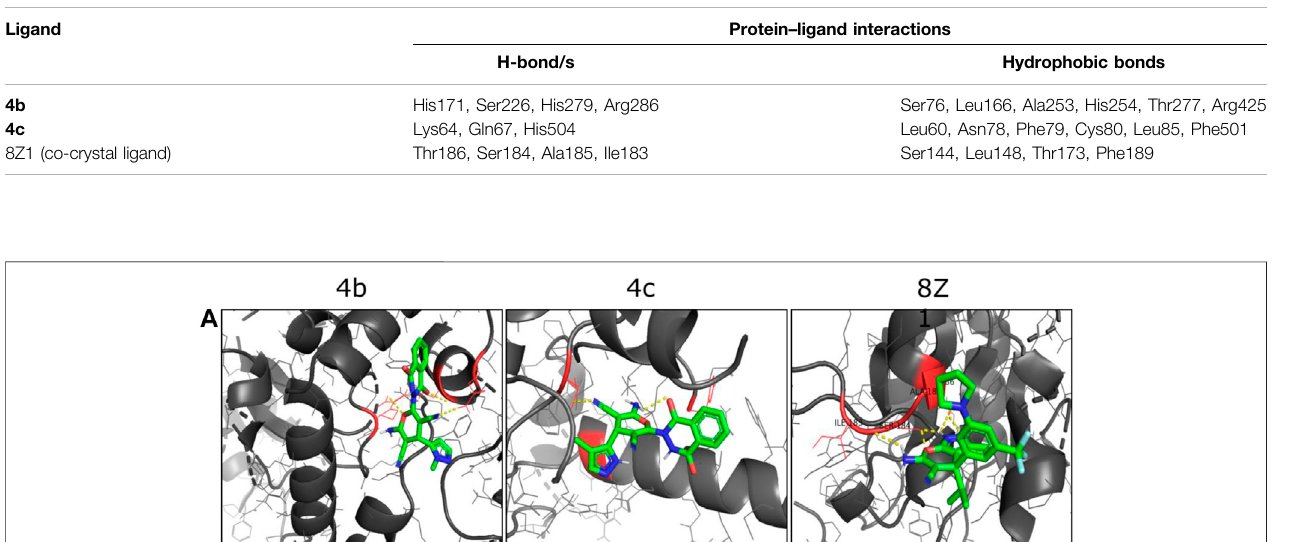
Frontiers in Chemistry |